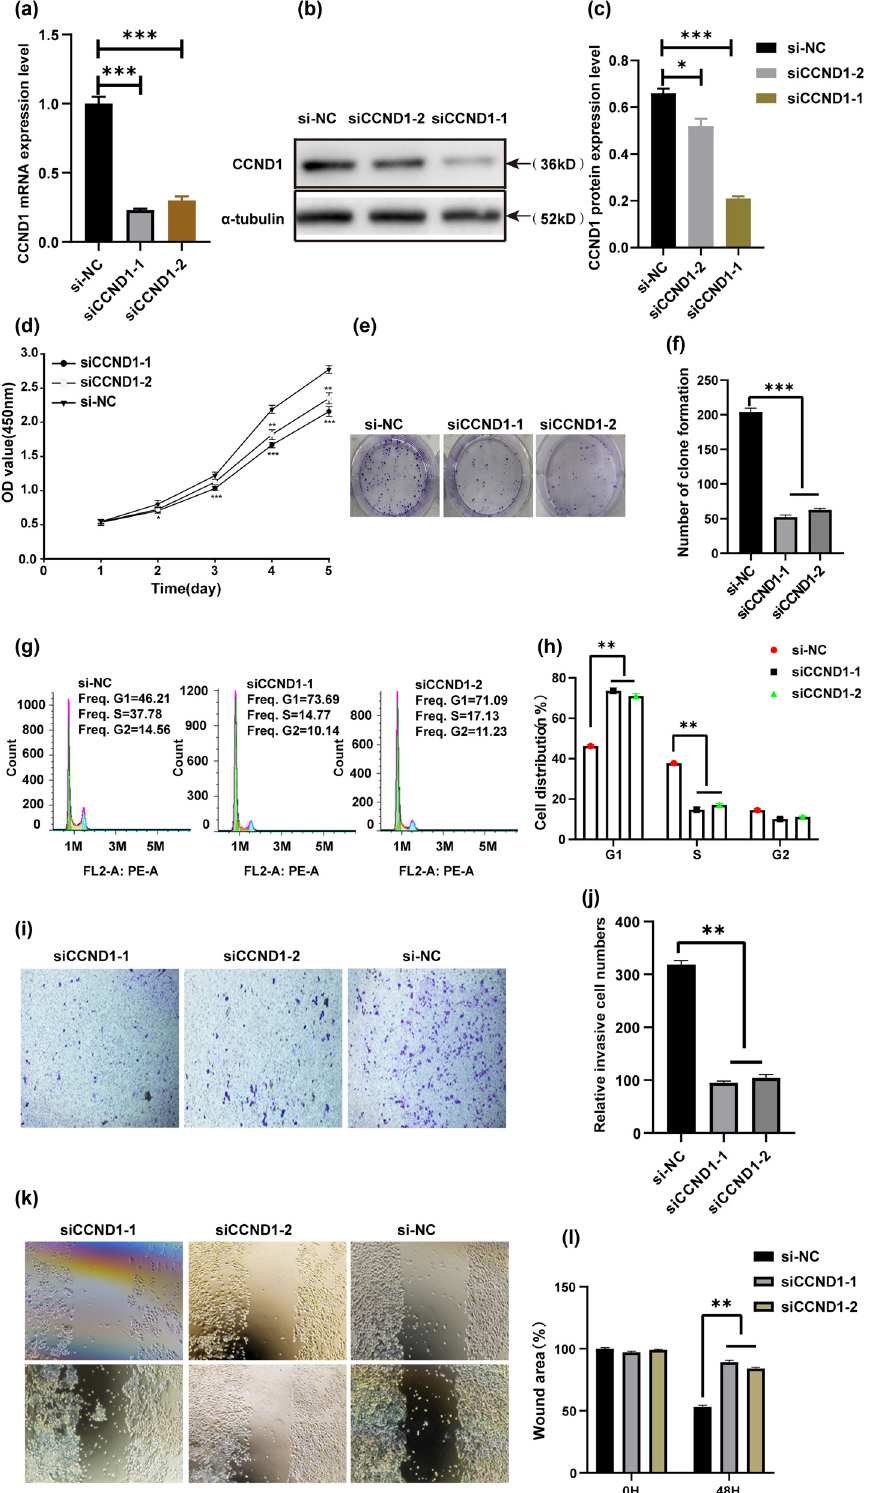
Figure 4: siCCND1 inhibits the proliferation, cell cycle, migration, and invasion of HCT116 cells. ( a ) QRT - PCR was used to detect the mRNA expression of CCND1 in siCCND1 and siNC. ( b ) Western blot was used to detect the protein expression of CCND1 in si - CCND1 and siNC and a statistical histogram was shown at right ( c ) . ( d ) CCK - 8 assay was used to detect the HCT116 cell viability after the knockdown of CCND1. ( e ) A colony formation assay was used to detect the cell colony formation ability after the knockdown of CCND1 and a statistical histogram was shown at right ( f ) . ( g ) Cell cycle distribution was measured by fl ow cytometry and a statistical histogram was shown at right ( h ) . ( i ) Transwell assay was used to detect the invasion of HCT116 cells after knocking down CCND1 and a statistical histogram was shown at right ( j ) . ( k ) The change in cell migration was examined by wound - healing assay in HCT116 cells after knocking down CCND1 and a statistical histogram was shown at right ( l ) . * P < 0.05, ** P < 0.01, and *** P <